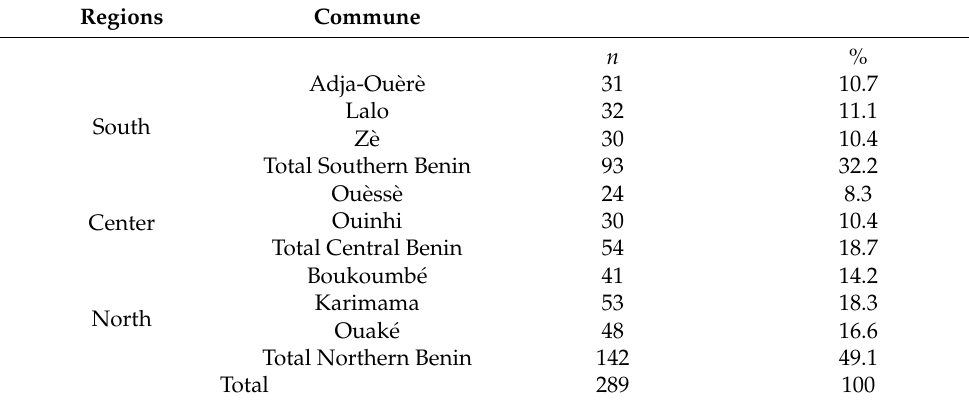
Table 1. Number of infants in the study ( n =